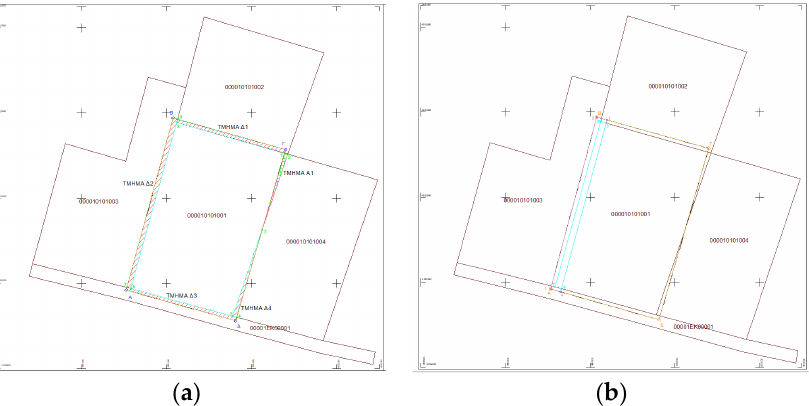
Figure 17. ( a ) Geometric correction of land parcel boundaries. ( b ) Geometric correction of passage easement (Source: [38]).